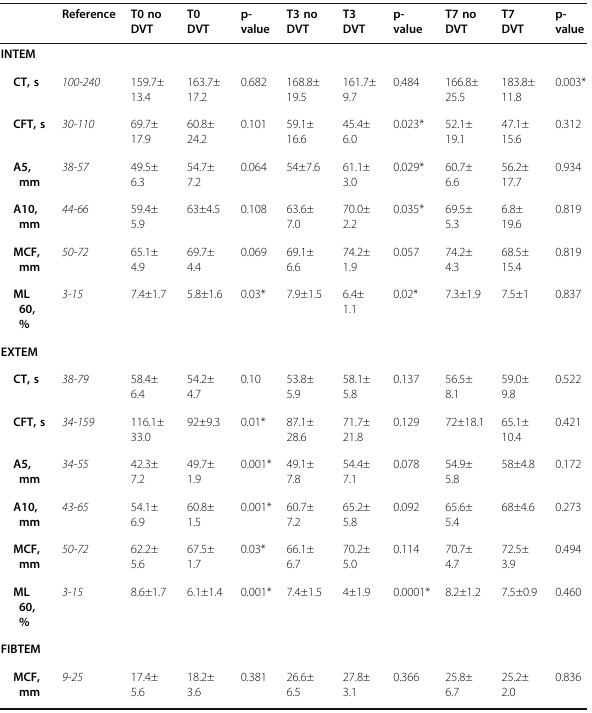
Table 1 (abstract A183). ROTEM parameters at T0, T3 and T7 in patients with DVT and those